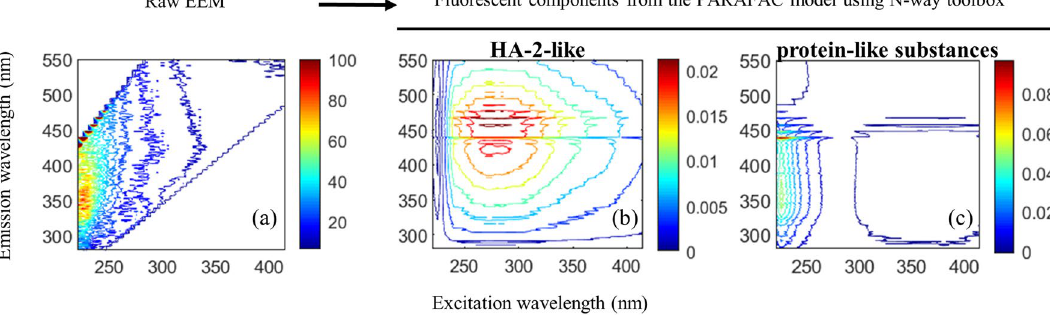
Figure 3. Original EEM spectra (left, a ) and the two fluorescent components ( b , c , right) identified by the EEM- PARAFAC model in isolated Fe-HA precipitates (Fe-HA P ) after dissolution at pH